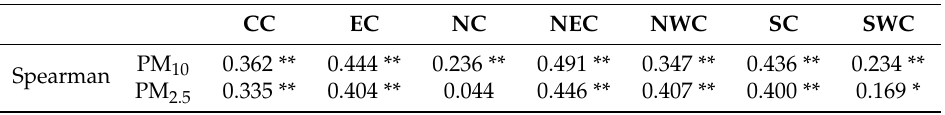
Table 3. The correlation between PM concentrations and crop residue burning occurred in different regions of China during burning-concentrated periods. CC EC NC NEC